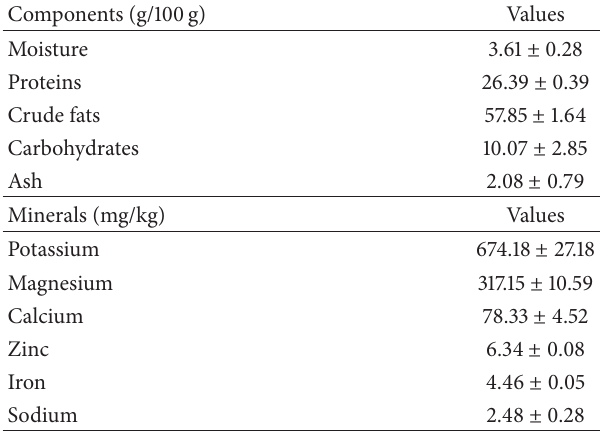
Table 1: Proximate and mineral compositions of Lannea kerstingii